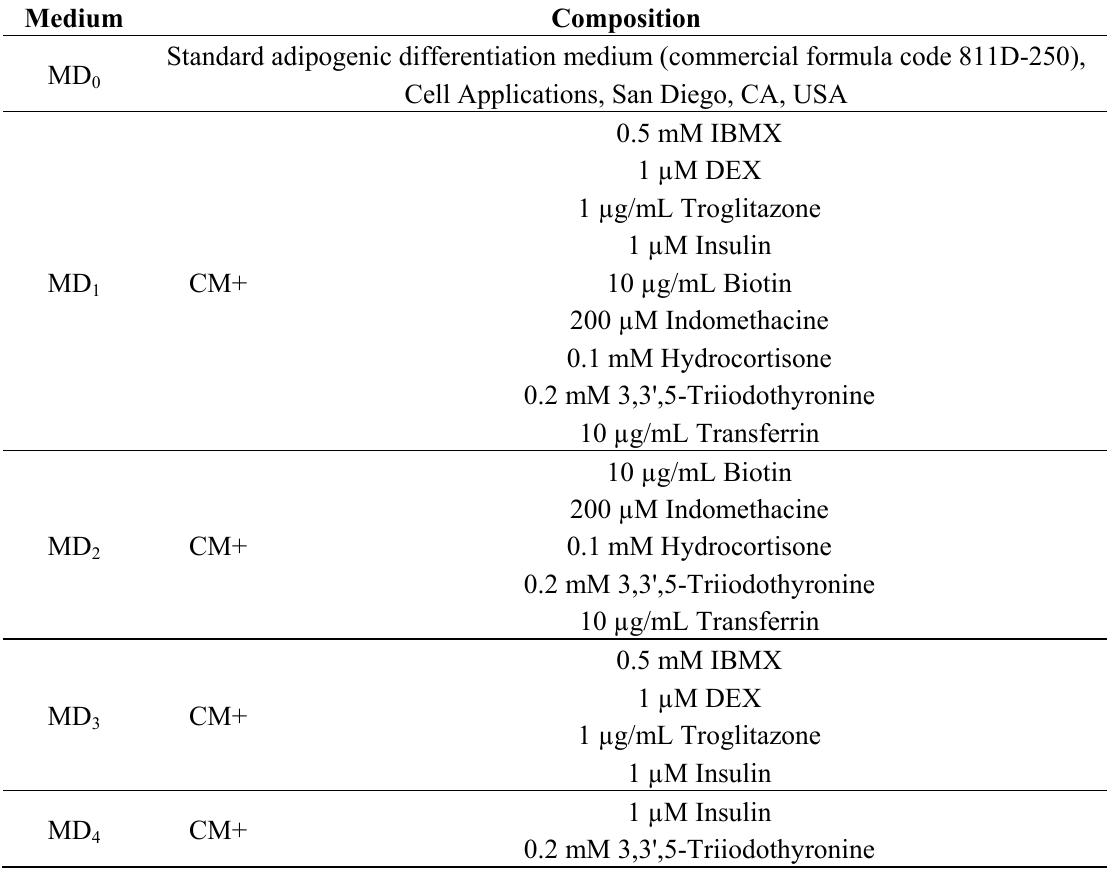
–P protocols during 21 days of 0 3